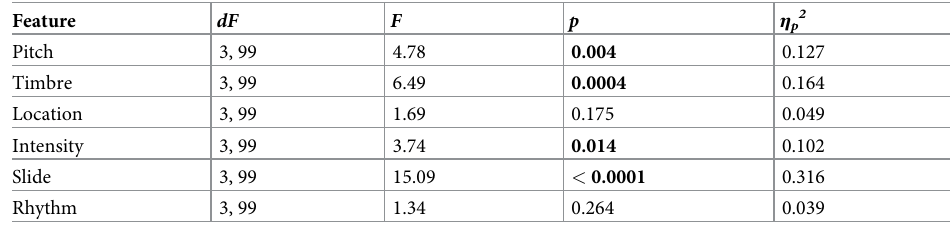
Table 4. ANOVA results for the MMNm